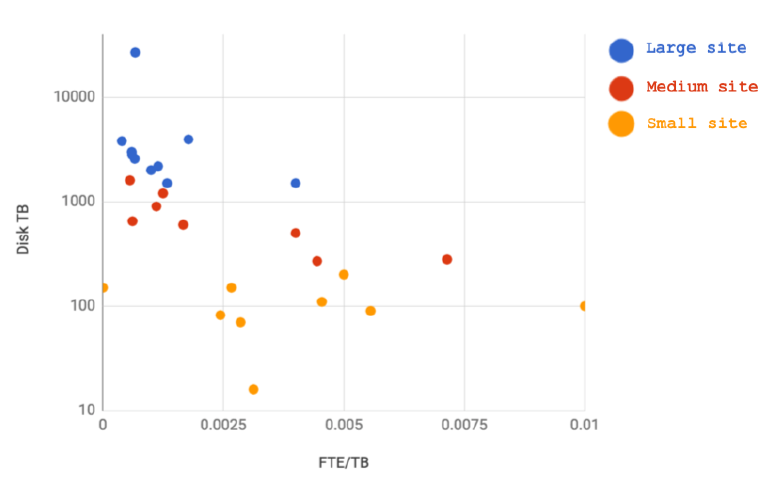
Figure 3. FTE needed per